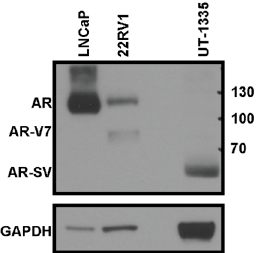
Figure 2. Expression of truncated AR in patient-derived xenograft (PDX). Prostatectomy specimen from an African American man was implanted subcutaneously in NOD-SCID Gamma (NSG) mice. Mice were euthanized and protein was extracted from the PDX, and Western blot for AR was performed with an antibody that binds to the NTD and for GAPDH.